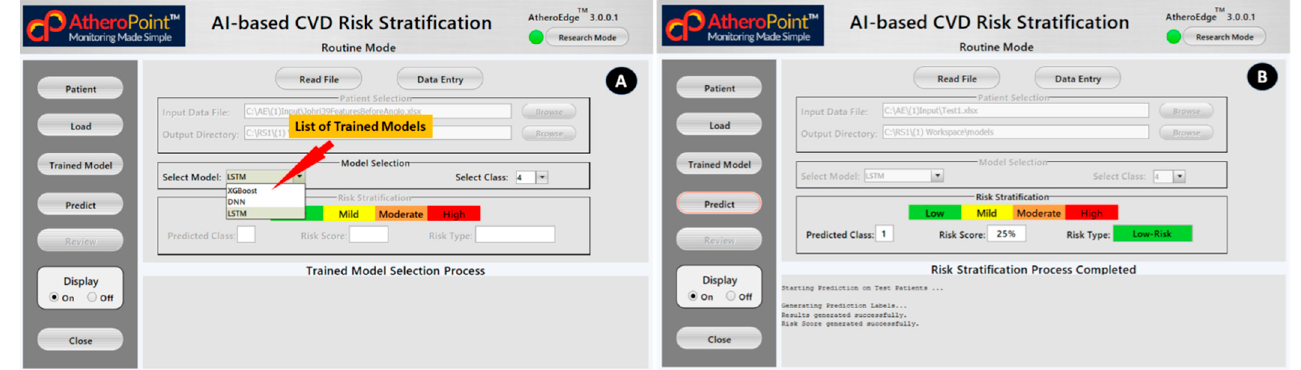
Figure 6. The graphical user interface of Atheropoint TM (3.0) AI ‐ based CVD Risk Stratification sys ‐ tem to predict a person’s 10 ‐ year CVD risk. ( A ) Trained Model Selection Process and ( B ) Risk Strat ‐ ification Predication Process [117]. (Courtesy of AtheroPoint, Roseville, CA, USA permission